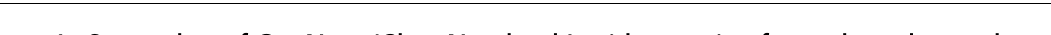
Figure 1. Screenshot of OneNote ‘Class Notebook’, with a section for each student, subsections for different teaching formats and pages for each session (student names pixilated for anonymity) (Source: Author,